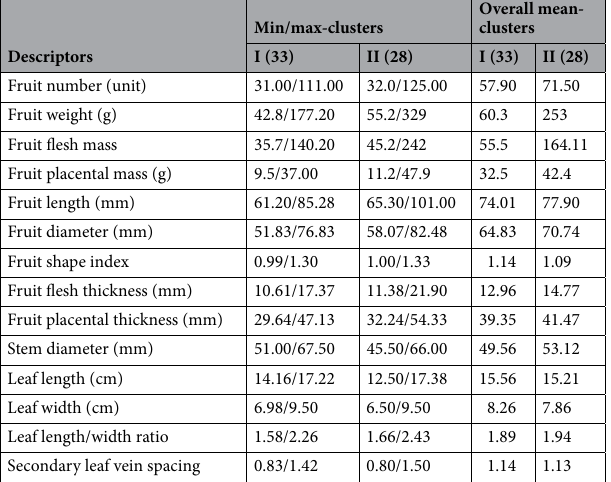
Table 4. Minimum, maximum, and mean values of the descriptors for each of the two groups formed by the Ward-MLM strategy in 61 genotypes of inbred S1 families of guava trees. UENF, Campus of Campos dos Goytacazes (Brazil), 2022. Minimum (Min) and maximum (Max) values for each of the two groups